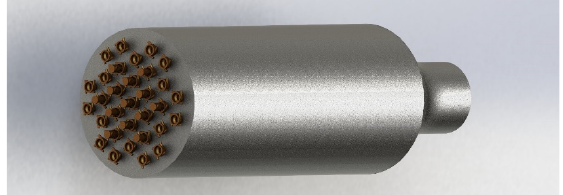
Figure 1. Structure of the combustion chamber.